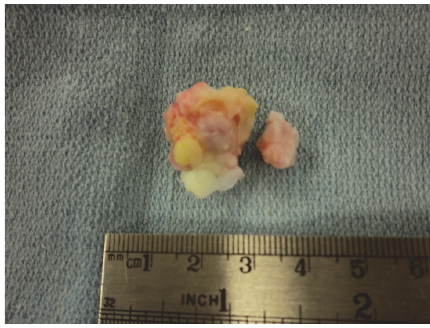
Figure 5: Gross pathological specimen of excised tumor.